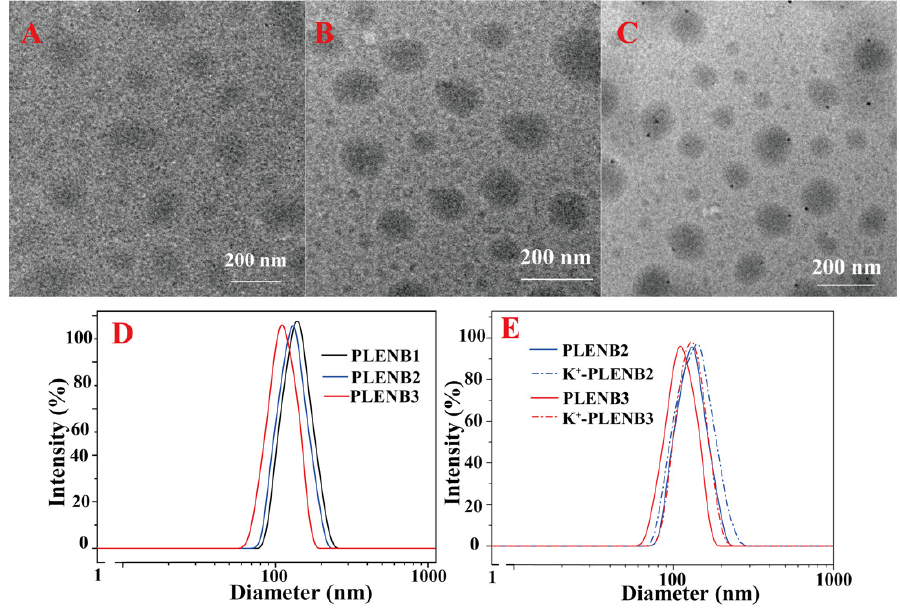
Figure 5. TEM diagram of ( A ) PLENB1, ( B ) PLENB2, ( C ) PLENB3 micelles, and DLS of ( D ) PLENB micelles, ( E ) PLENB micelles/K + solution.